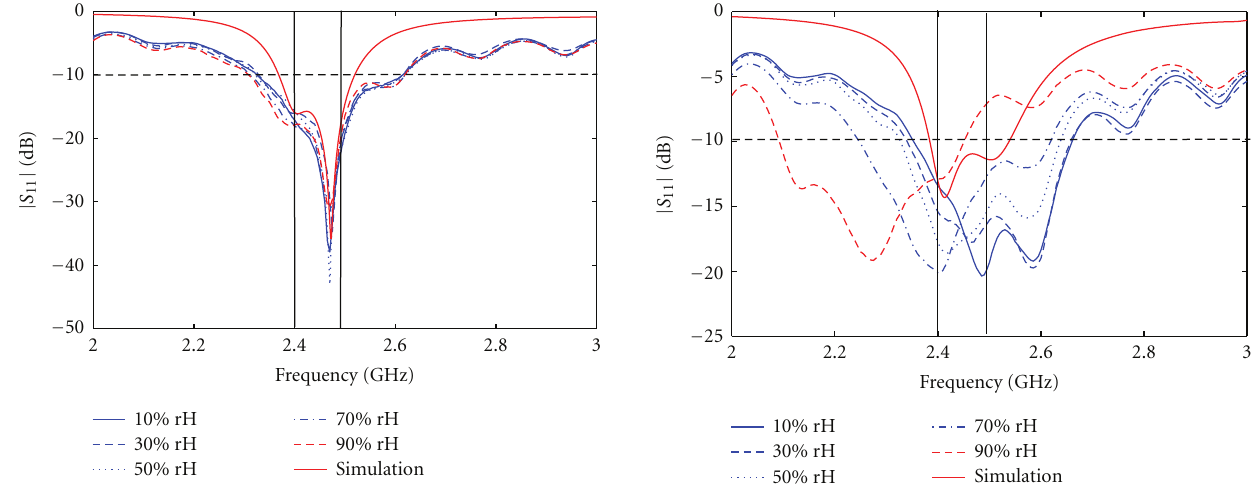
Figure 11: Array on cotton: reflection coe ffi cients, simulation (full line) versus measurements (dashed line).